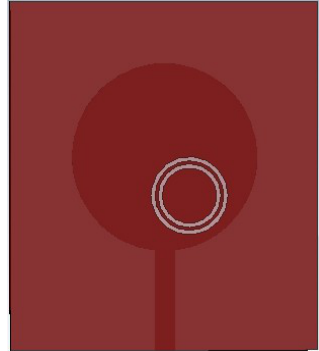
Figure 6: Patch with CRR defected ground.